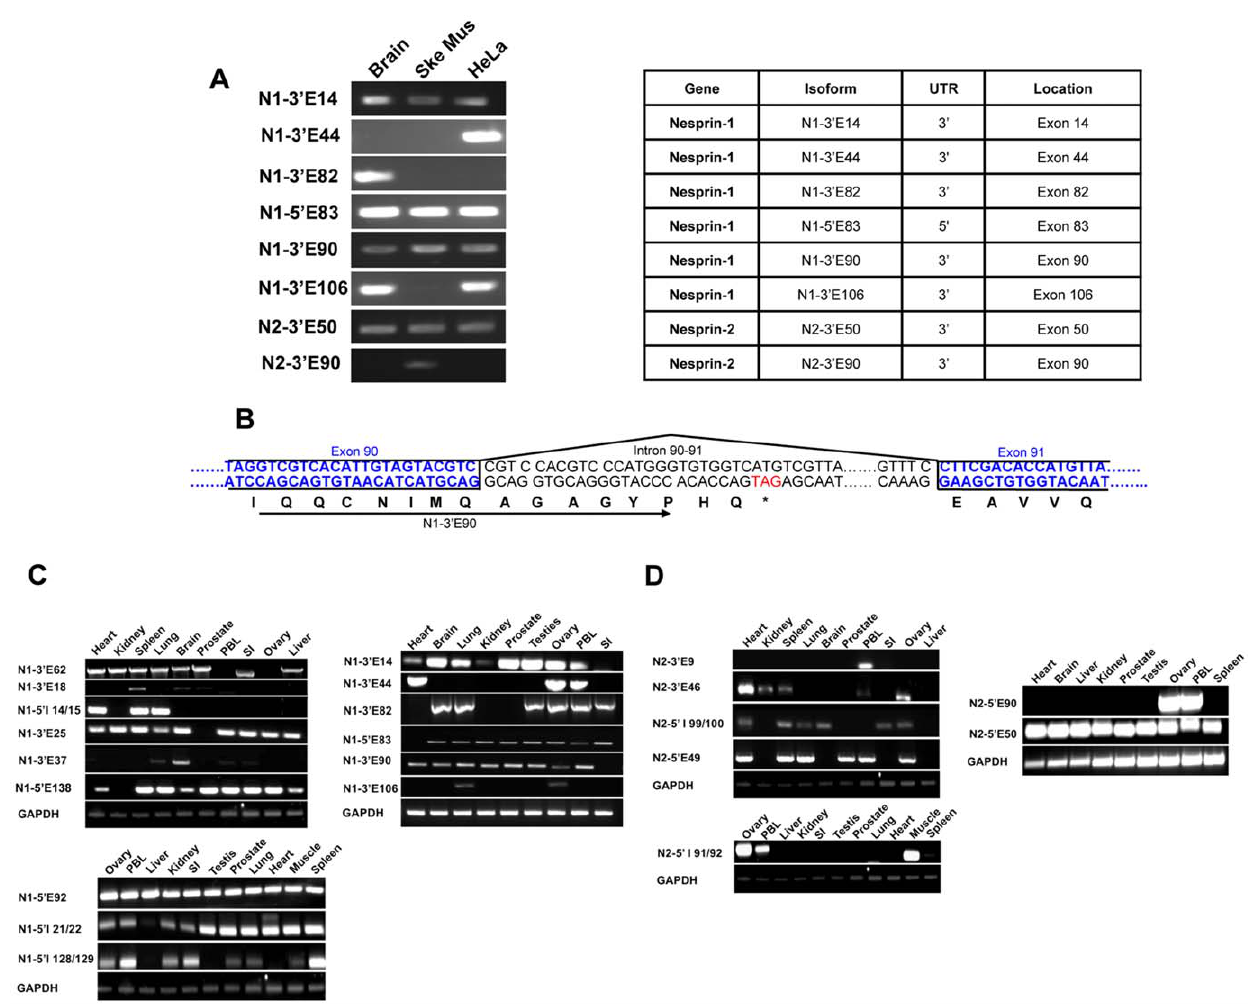
Figure 1. Identification of novel nesprin UTRs. A) cDNA ends identified by 3 9 and 5 9 RACE from Brain, Skeletal Muscle (SkeMus) and HeLa cDNA libraries. B) DNA sequencing results suggest that nesprin isoforms terminate with unique C-terminal ends absent from the giant isoforms as a result